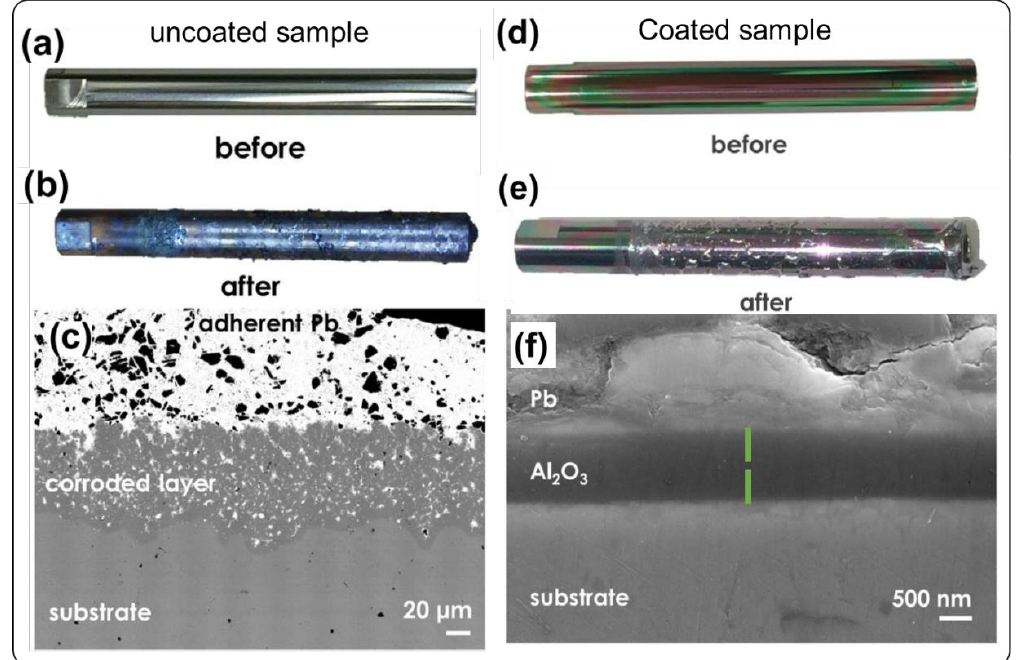
Figure 11. Corrosion resistance evaluation of Al 2 O 3 coatings on the cladding tubes. ( a – c ) the surface of cladding tube before after corrosion and its cross-section image. ( d – f ) The appearance of cladding tube before and after corrosion and its cross- section image [86]. Figure 11 is reprinted with permission from [86]. Copyright 2017 Elsevier.